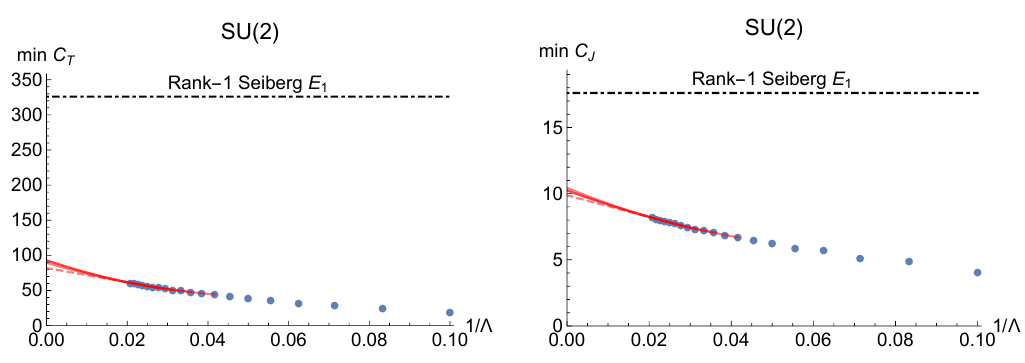
Figure 5. Lower bounds on C T and C J for interacting theories with SU(2) (cid:13)avor group, at various derivative orders (cid:3) and extrapolated to in(cid:12)nite order using the quadratic ansatz (5.21) (solid) and the linear ansatz (5.22) (dashed). Also shown are the values of C T and C J in the rank-one Seiberg E 1 theory